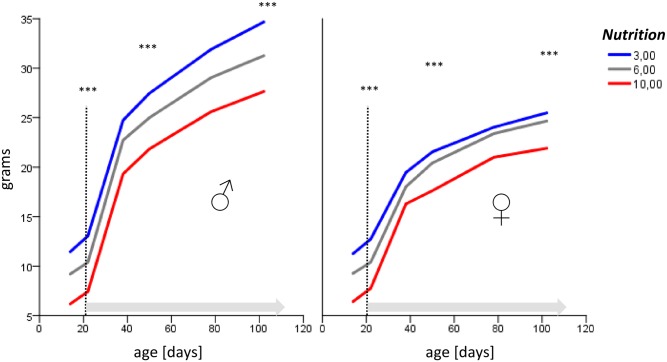
Body weight in grams (y-axis) and age in days of postnatal development (x-axis), longitudinal data of a P100 cohort.Note that differences between the nutrition groups (3, 6, and 10 pups per mother, respectively) persisted after weaning and redistribution at P21 (dotted line), after which mice had free access to standard food.